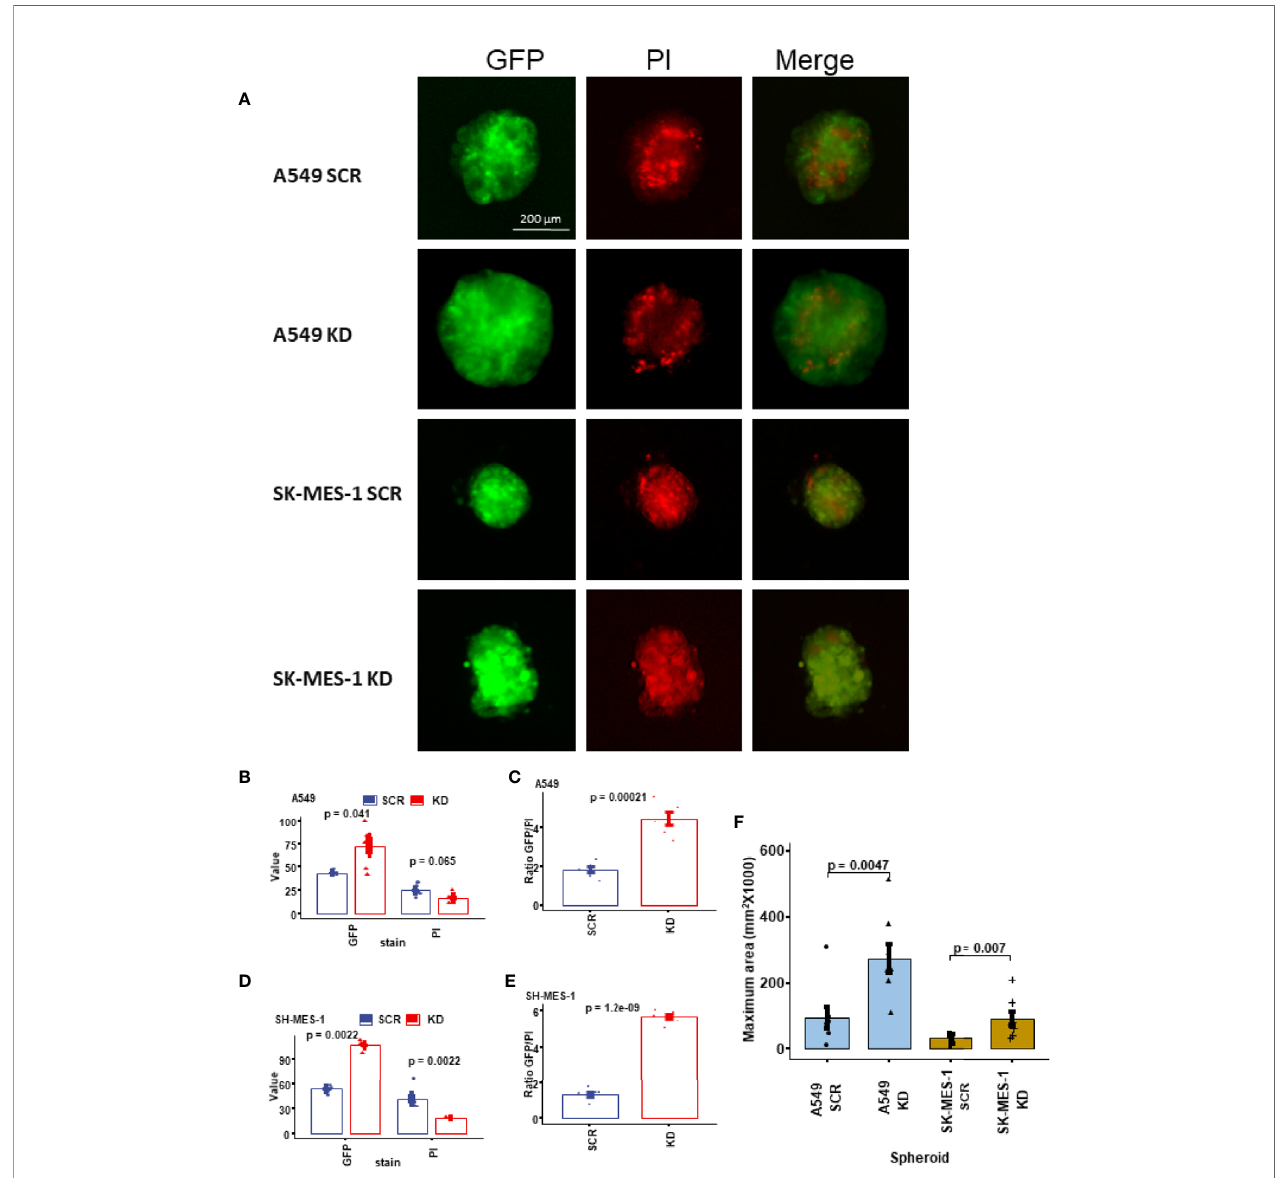
FIGURE 4 | Growth and viability analysis of the 3D tumour spheroids. (A) Representative images of the lung cancer cell spheroids. The spheroids were stained with propidium iodide (PI) to indicate cell death. (B) The value of GFP and PI in the stable A549 cell lines. (C) The ratio of GFP/PI in the stable A549 cell lines indicating the viability level. (D) The value of GFP and PI in the stable SK-MES-1 cell lines. (E) The ratio of GFP/PI in the stable SK-MES-1 cell lines. (F) Comparison of the sizes (indicated by the maximum area) of the